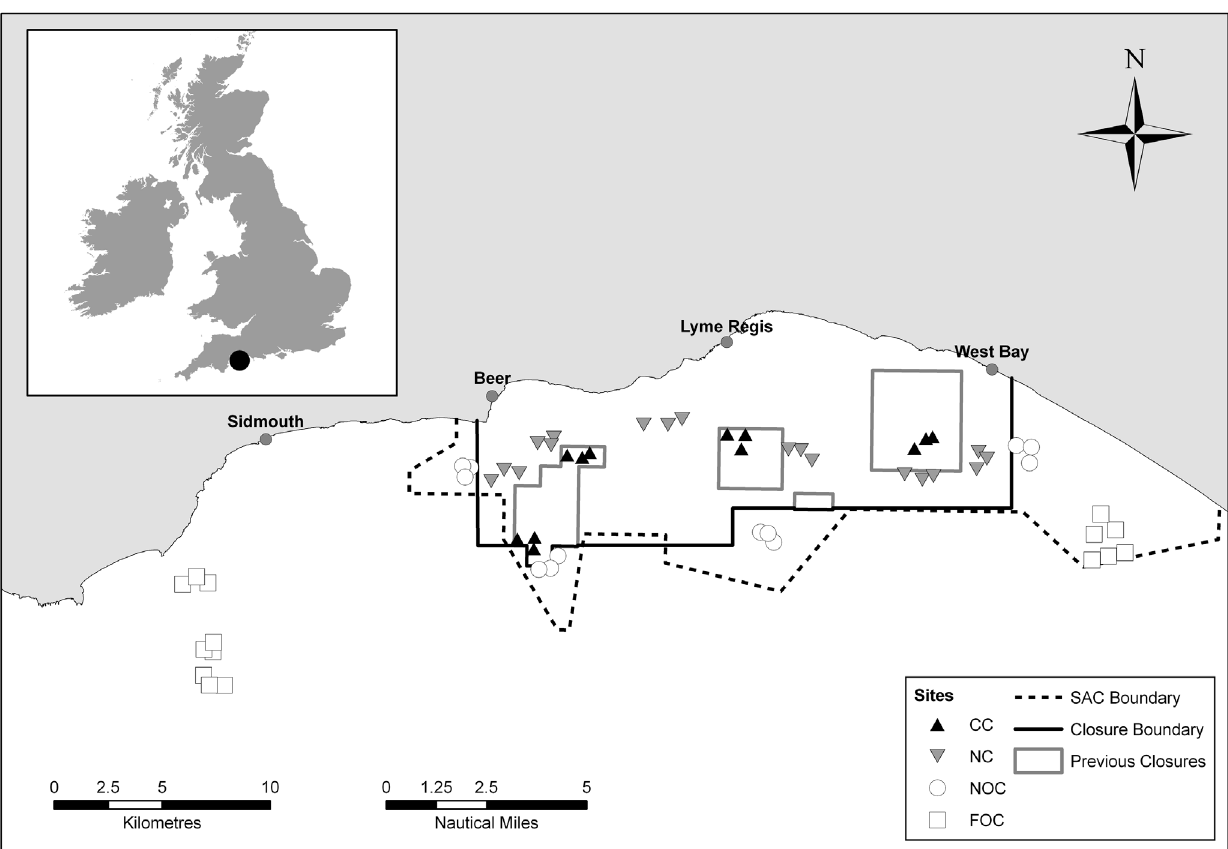
Figure 1. Locations of sites in Lyme Bay. Some symbols overlap at this scale.